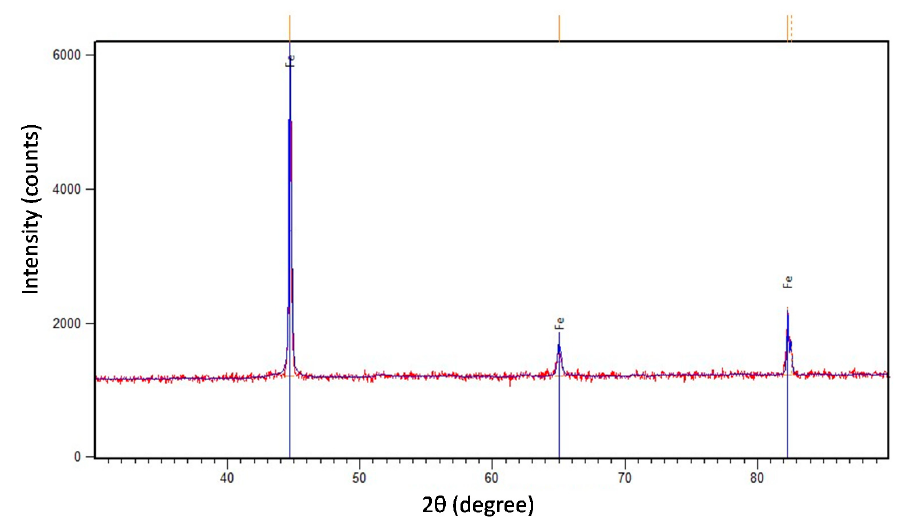
Figure 12. XRD pattern.